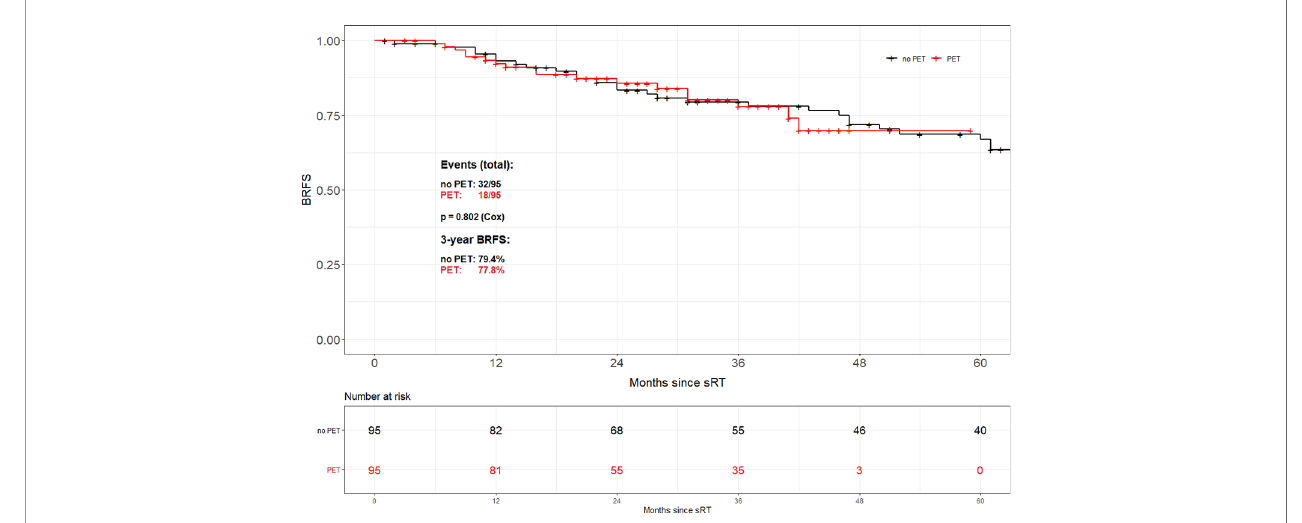
FIGURE 2 | Biochemical recurrence-free survival according to the use of PSMA PET/CT after propensity score